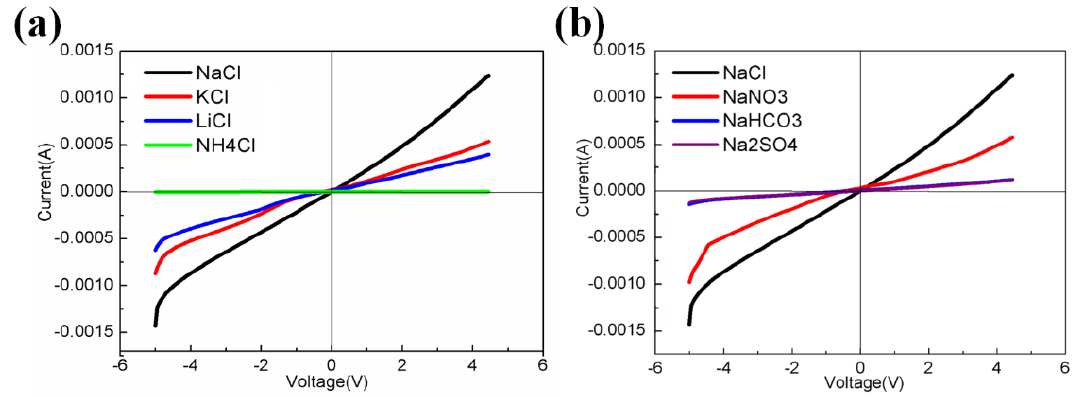
Figure 11. Current–voltage properties of membrane M3: ( a ) different transported cations with the same anion Cl − , ( b ) different transported anions with the same cation Na + .